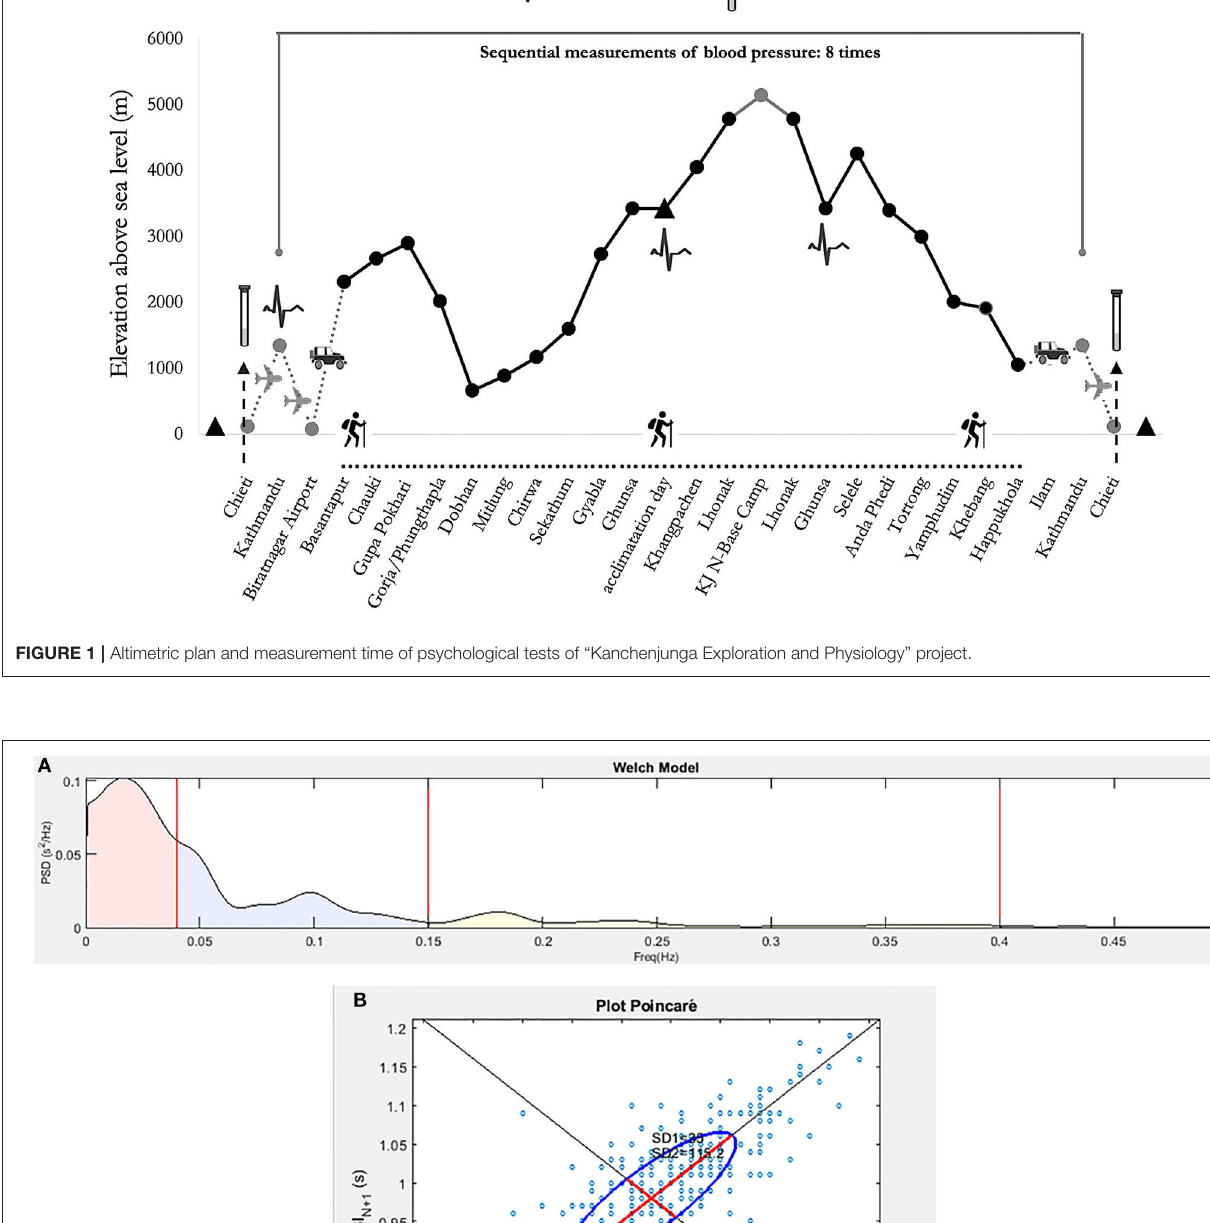
Frontiers in Physiology |